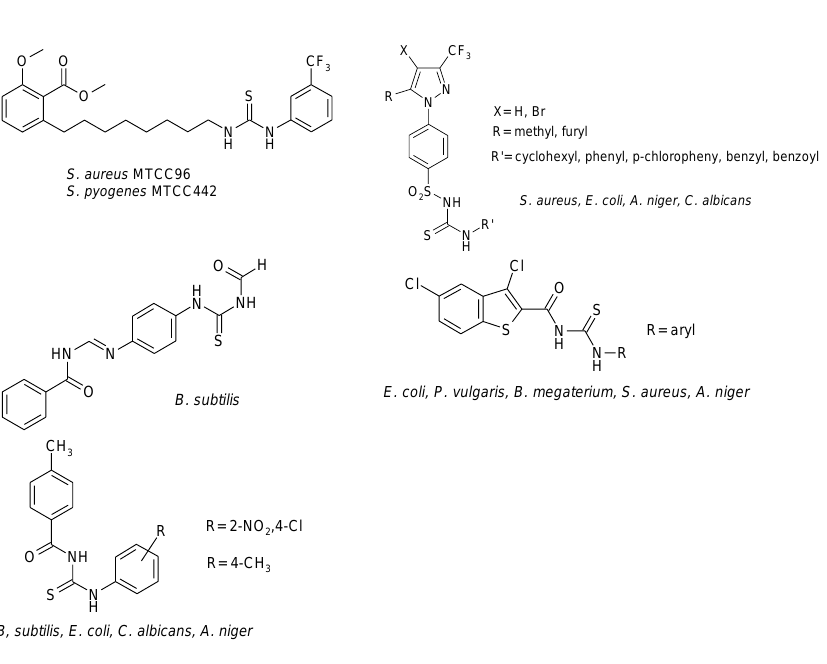
Figure 1. Antimicrobial thiourea derivatives.